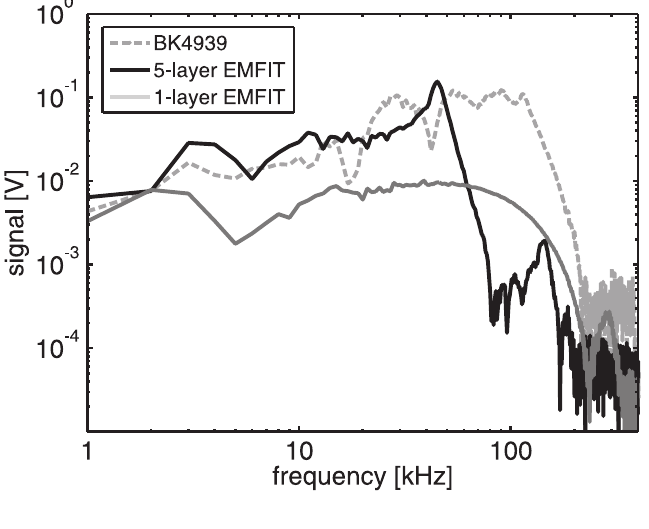
Figure 2. Photoacoustic response of a stack of 5-layer EMFIT film microphone in free field, compared with the responses of a 1-layer film and a reference condenser